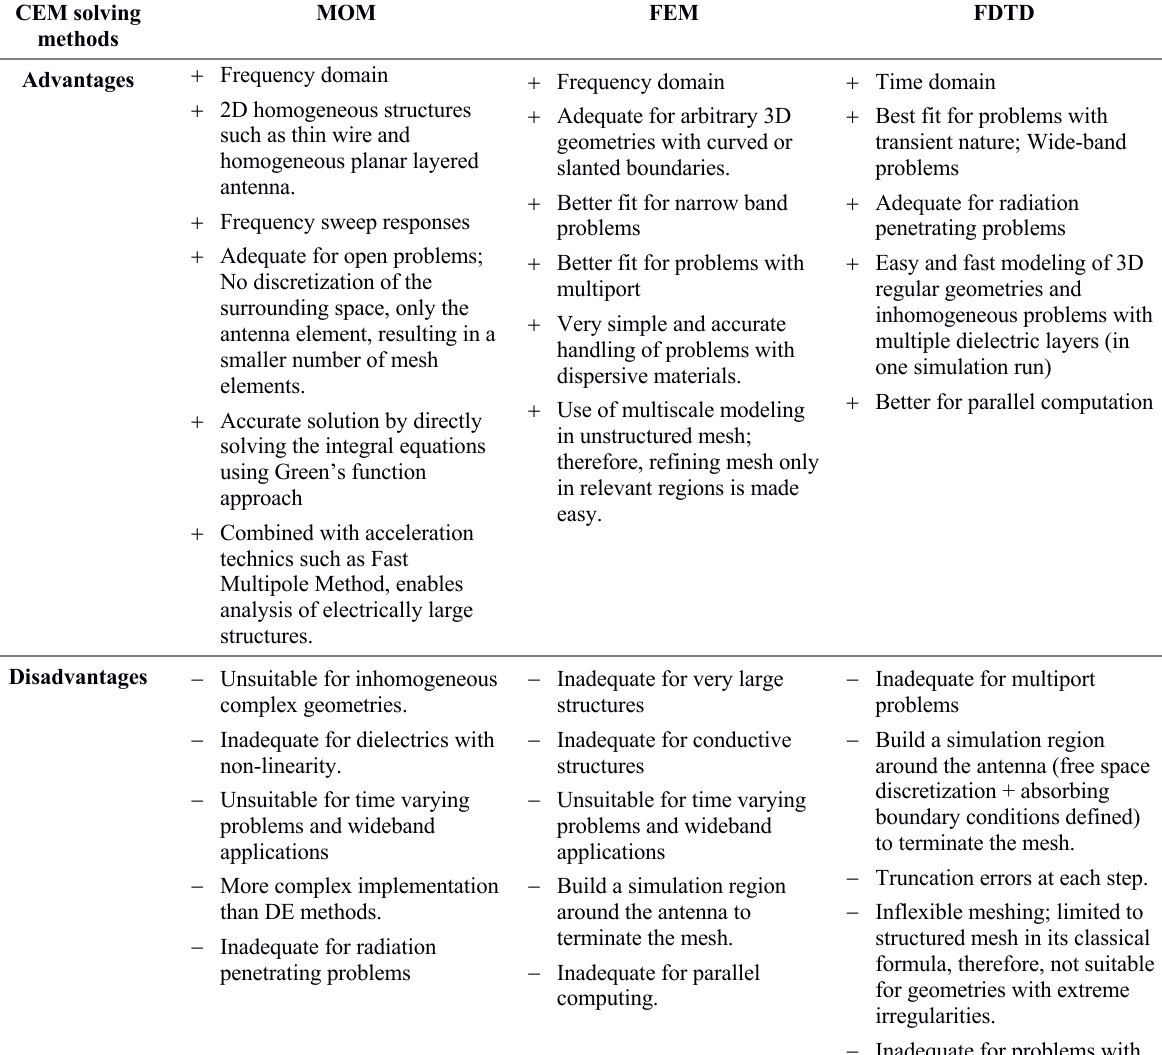
Table III. pros and cons of CEM solving methods CEM solving